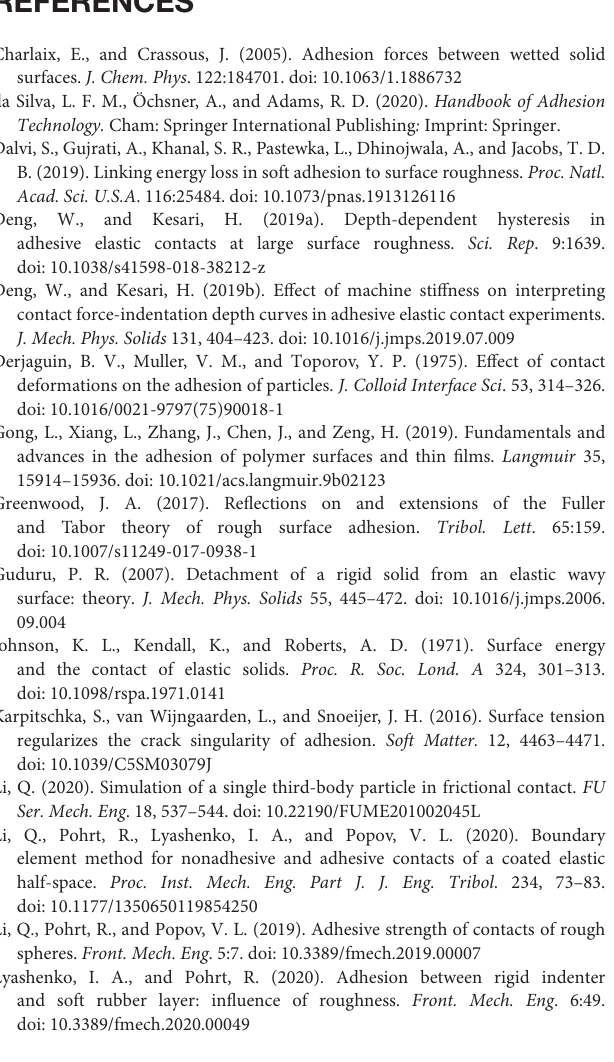
µ m/s. Ten identical steel spheres with diameter 1mm were located on the rubber. Panels from left to right show the contact configuration and the dependencies of normal force and direct contact area between indenter and elastomer on the indentation depth. In the dependencies of the contact area, the experiment duration in seconds is shown. The video corresponds to Figure 8 . Supplementary Video 7 | Video of simulation for indentation of rigid sphere with radius 100mm in an elastic layer with thickness of h = 10mm, Young modulus E = 0.283 MPa and Poisson’s ratio ν = 0.47. Ten identical micro steel spheres with diameter 1mm were located on the rubber. Panels from left to right show the contact configuration and the dependencies of normal force and direct contact area between indenter and elastomer on the indentation depth. Surface energy in the indenting process is very small, γ 0 = 0.0175 J/m 2 . In the pull-off phase, it is zero in the region where particles are located and γ 1 = 7.5 J/m 2 in the remaining region. In the subsequent three cycles γ 1 = 6.0, 4.9 and 4.4 J/m 2 . Contact zones are shown in different colors: black—noncontact area where no particle located; red—noncontact areas where particles located; green—area of direct contact between elastomer and indenter; blue—area of contact between indenter and particles. The movie corresponds to Figure 9